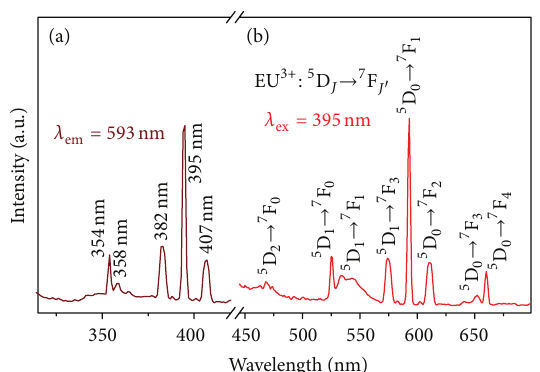
Figure 3: (a) Photoluminescence excitation spectrum of Yb 2 O 3 : 1% Eu 3+ nanocrystals by detecting the emission at 593 nm and (b) emission spectrum under the excitation at 395nm.